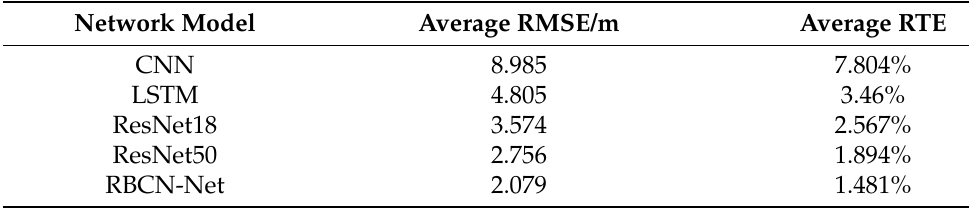
Table 3. Position evaluation of five competing